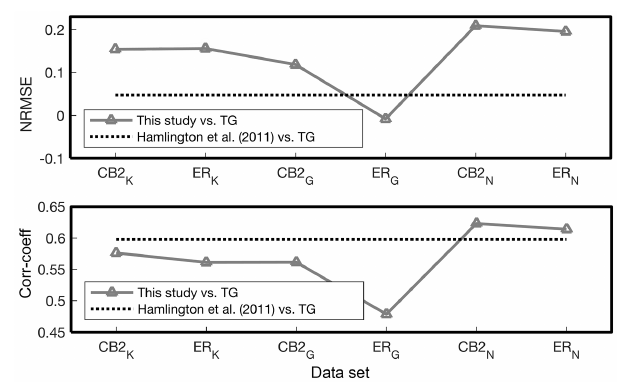
Figure 8. Results of the goodness-of-fit test for reconstructed mean SLA according to Hamlington et al. (2011) and TG mean SLA; the top panel includes normalized root mean squared error and the bot- tom includes the correlation coefficients; here, subscripts K, G, and N represent around the Korean Peninsula, global, and the northwest Pacific, respectively, and CB2 and ER represent COBESST2 and